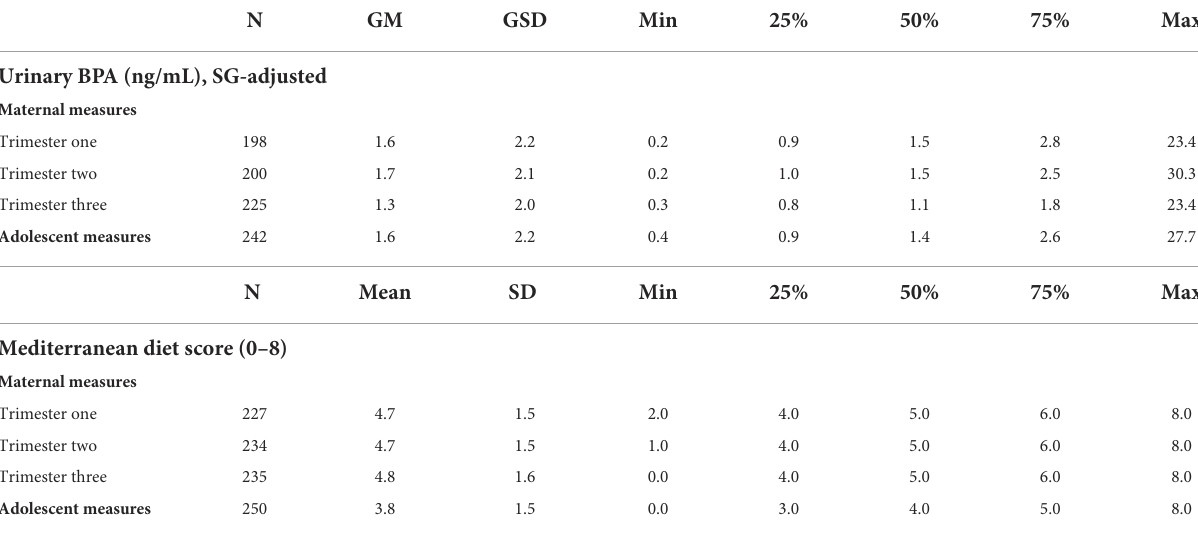
TABLE 3 Distribution of exposure variables from prenatal and adolescent exposure periods.